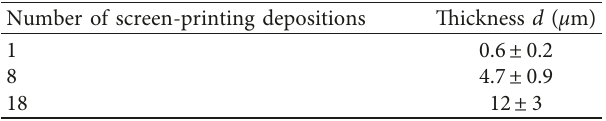
Table 1: Relation between the thicknesses of the used porous TiO 2m layers and the number of screen-printing depositions. Number of screen-printing